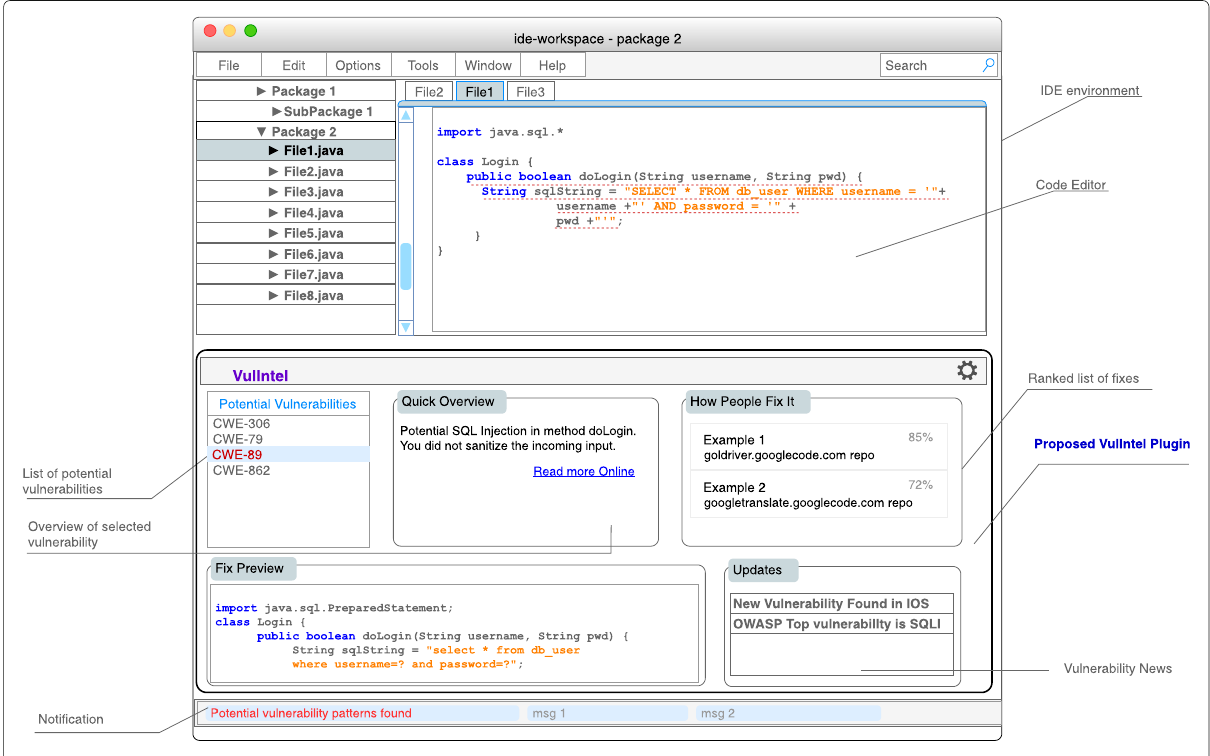
Fig. 3 Mockup of proposed system as incorporated in an IDE